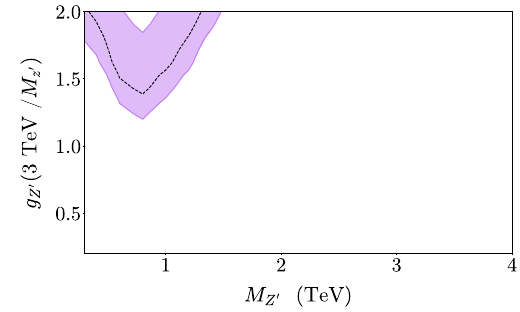
Fig. 22 EffectsoftheoreticaluncertaintiesonboundsfromtheATLAS di-tau search [66]. The dashed black line shows the central limit. The purple region falls between bounds obtained from upper and lower estimates of the cross-section accounting for systematic uncertainties. Toward the extreme left-hand side of the plot, our predictions become more inaccurate due to unaccounted-for O ( M 2